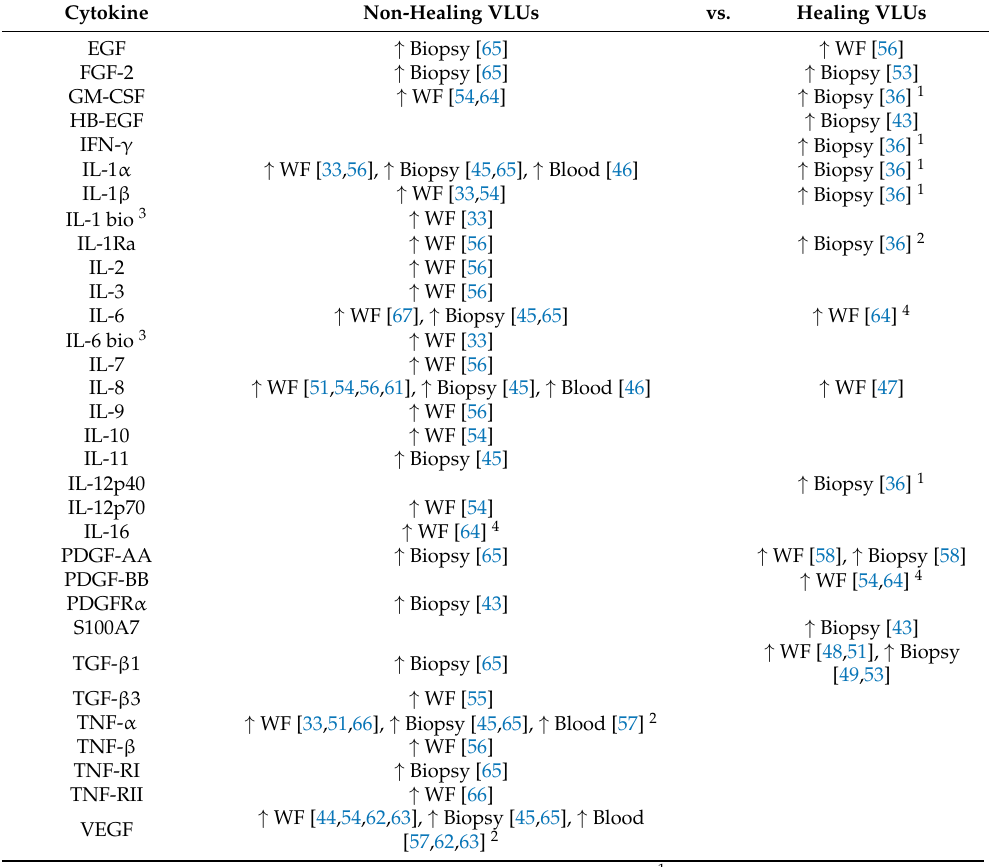
Table 2. Impact of cytokines on VLU healing